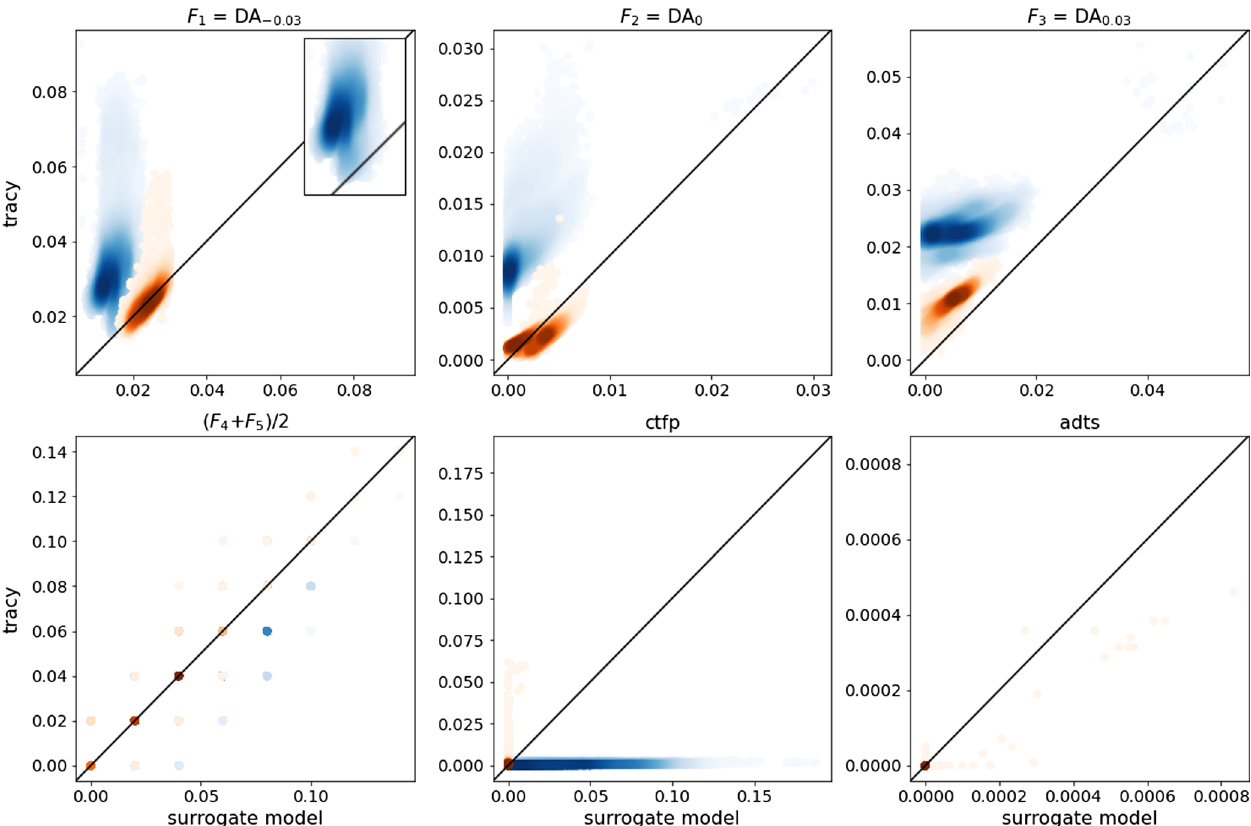
FIG. 4. Blue color: the quality of the predictions of the surrogate model from Fig. 3 on the design points in generation 1000 (computed with the approach from Sec. VA). For all points the value of adts is computed as zero using TRACY and predicted to be zero using the surrogate model. Orange color: the quality of the predictions of the third surrogate model from the approach in Sec. V B on the design points in generation 1000. In each subplot the x and y coordinates are the values computed with the surrogate model and TRACY , respectively (a point on the line y ¼ x would be perfect agreement). Darker colors represent higher design point densities. Since the plot in the first row, first column contains some overlap, the blue part underneath is shown in the top right corner. There is virtually no overlap in the second and third column of the first row. In the second row it can be concluded that the blue regions are located below the orange ones whenever the blue color is virtually absent from the plot — this is the case in the first and third column of the second row. The benefit of the approach from Sec. V B can clearly be seen. First, the orange regions overlap better with the line y ¼ x which means that the surrogate model predictions at the end of the optimization are more accurate. Second, the orange points mostly have smaller y coordinate values which means that they have better objective function values as computed with TRACY